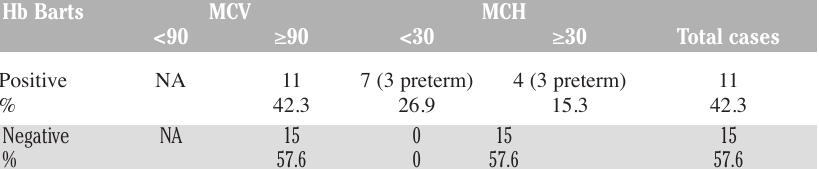
Table 2. Results on cord blood of test